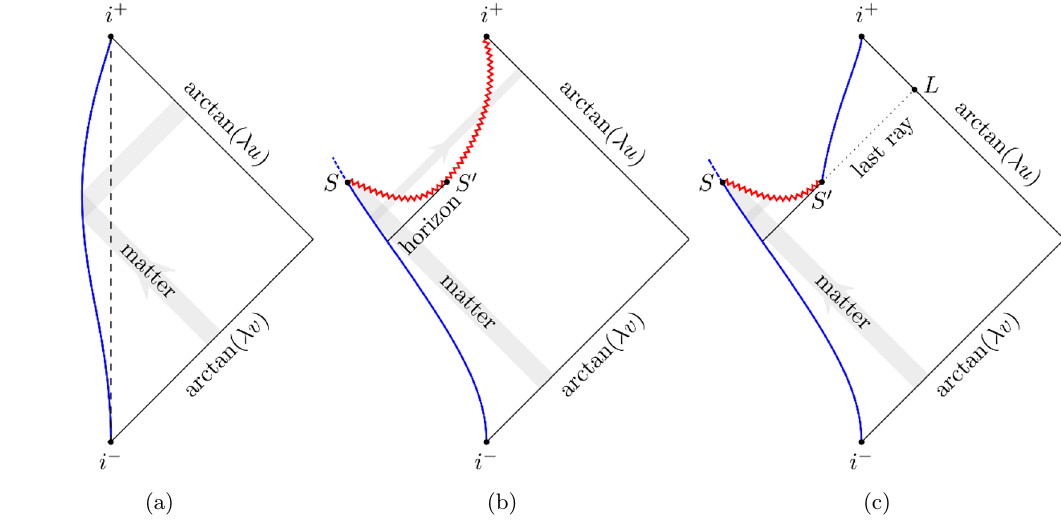
Figure 2 . Numerical evolution of the wave packet (3.16) in the one-loop RST model; the respective parameters are Q = 0 : 5, (cid:27) = 8 : 5 (cid:21) , and v 0 = 0 : 7 =(cid:21) . For visualization purposes we set (cid:30) 0 = 0. (a) Low-energy re(cid:13)ection at A = 2 : 5 (cid:21) 2 . (b) Black hole formation and evaporation at high energies: A = 10 (cid:21) 2 . (c) Natural extension of the solution